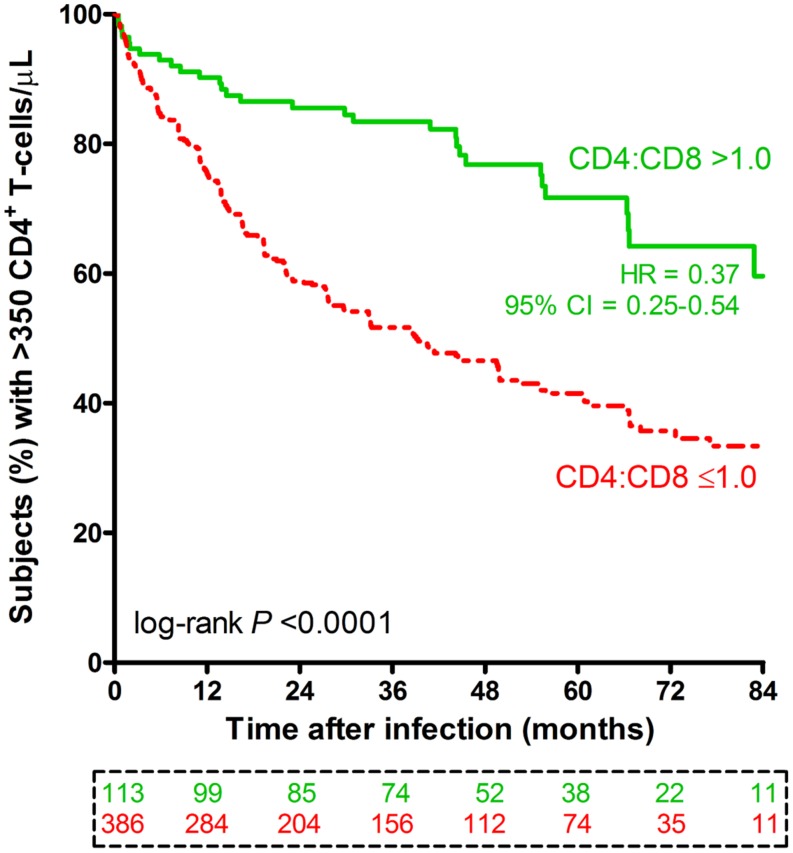
Progression to severe immunodeficiency among 499 HIV-1 SCs stratified by early CD4:CD8 ratio. Based on the first CD4:CD8 ratio measured beyond the initial 3-month period of infection, subjects are divided into two subgroups (CD4:CD8 ratio >1.0 in green color versus ≤1.0 in red color). The first of two consecutive visits with CD4+ T-cell count <350 cells/μL is plotted as the event time (Amornkul et al., 2013). The numbers of subjects available at nine time points are boxed and color coded. The crude hazard ratio (HR) and 95% CI are based on a Cox proportional hazards model (unadjusted). The adjusted model is shown in Table 3.